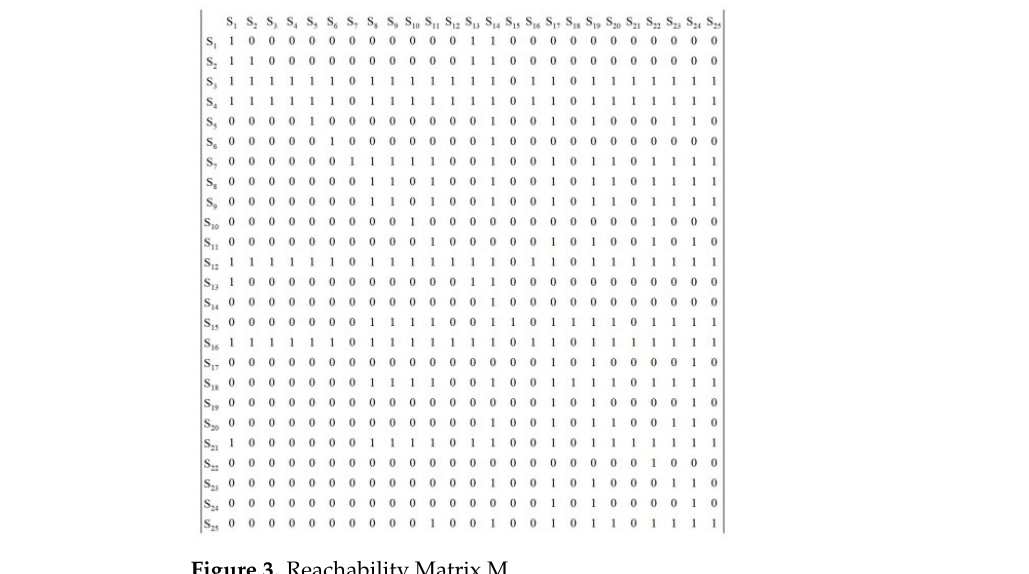
Figure 3. Reachability Matrix M. Table 2. Level